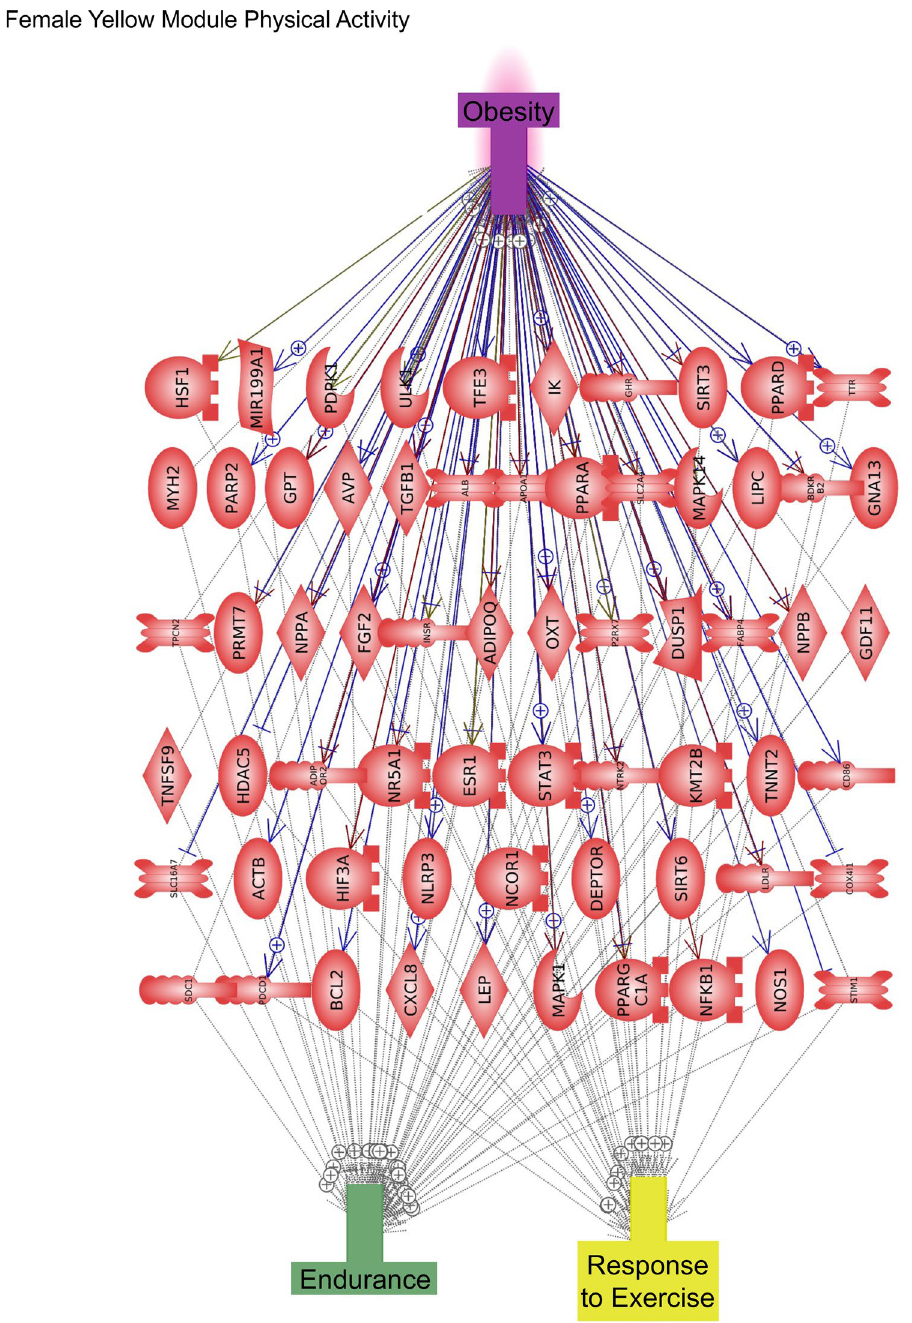
Figure 10. Female Yellow module-trait physical activity. Twin epigenetic site gene association network analysis. Female yellow module physical activity. Gene links in common for obesity and physical activity